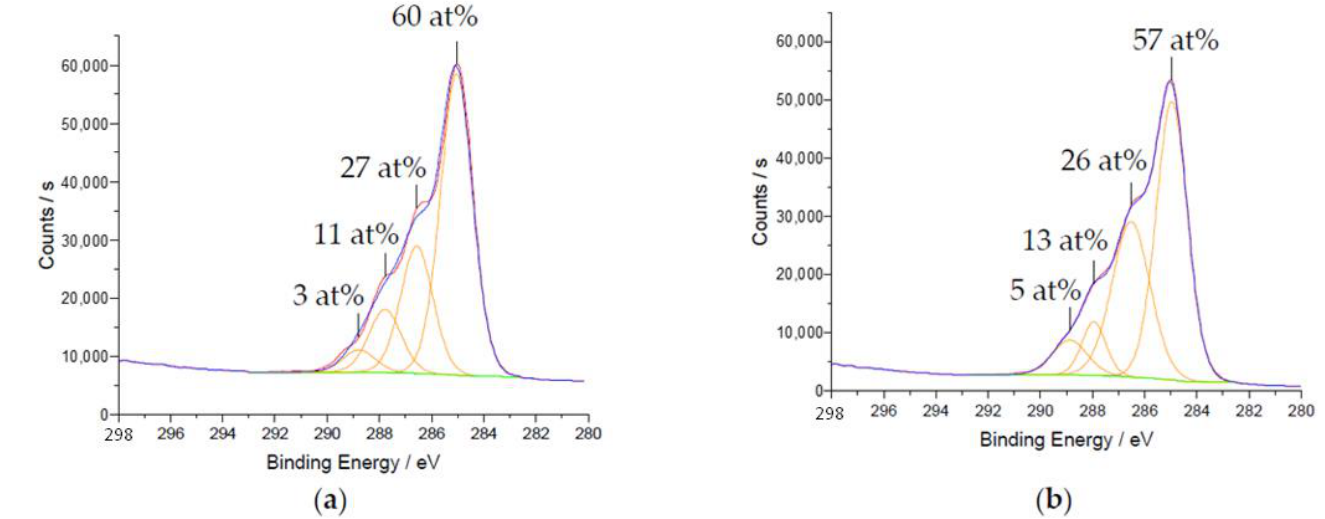
Figure 7. C 1 s high-resolution XPS spectra and percentage of the different binding energies of pp lim (lim flow rate of 10 g h −1 ) deposited using ( a ) air; ( b ) N 2 as ionization gases.